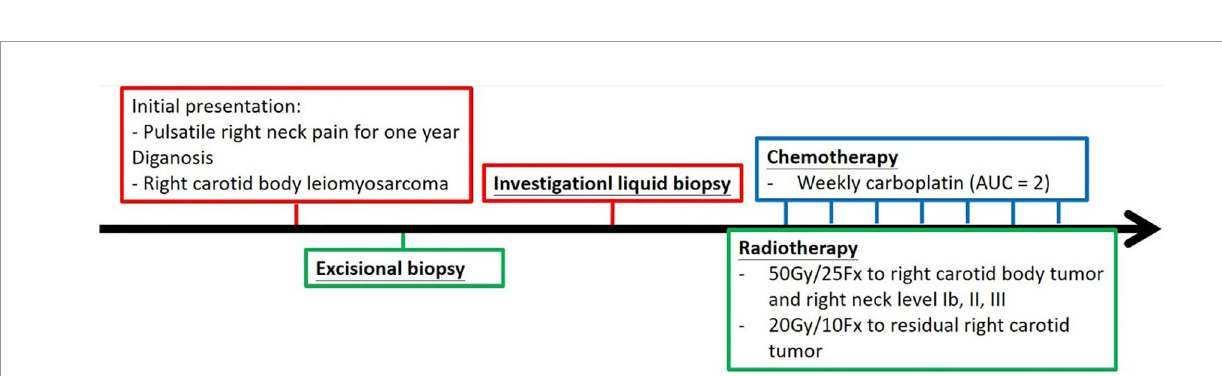
FIGURE 2 | Irradiation 50Gray (Gy) in 25 fractions (Fx) was delivered to carotid body tumor and right neck regional lymphatics (level Ib to level III) (Left) followed by boost radiotherapy 20Gy in 10Fx to carotid body tumor (Right). The red and blue lines represented the clinical target volume and plan target volume respectively. The orange line and light blue lines represented the isodose line of the 100% and 50% prescribe dose in two phases of radiotherapy, respectively.